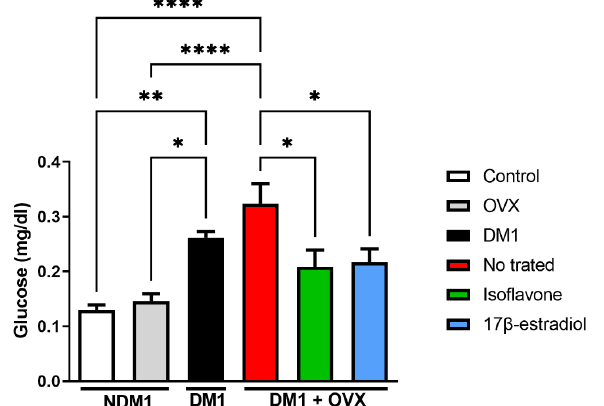
Figure 1. Isoflavone reduces glycemia. Blood glycemia was measured in mg/dL in non-diabetic, diabetic, and isoflavone- and 17β -estradiol-treated groups. Values represent mean ± SEM ( n = 6). Kruskal–Wallis test was performed, followed by Dunn’s multiple comparison test (* p < 0.05; ** p < 0.01; **** p < 0.0001).